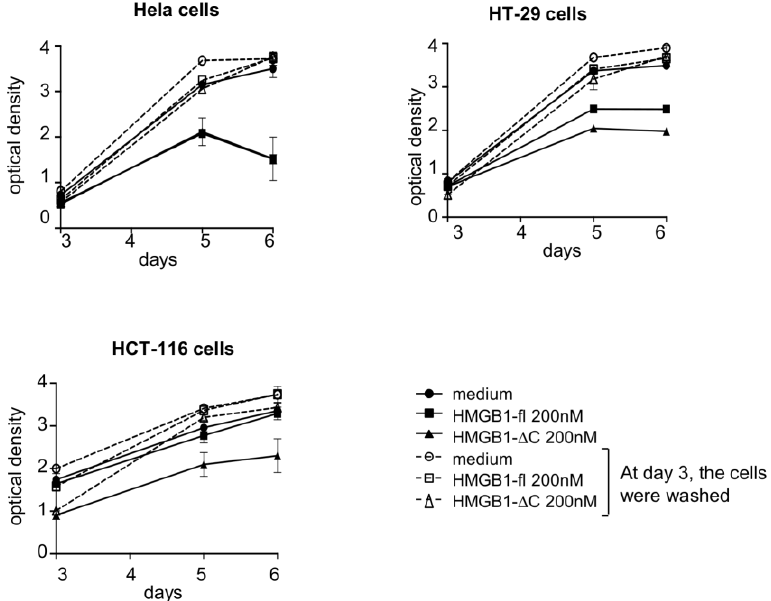
Figure 3. Cytotoxic versus cytostatic activities of HMGB1-fl and HMGB1- ∆C on cancer cells. HeLa, HT-29 and HCT-116 carcinoma cells were treated for 6 days (black symbol) with a fixed concentration (200 nM) of HMGB1-fl or HMGB1- ∆C. Alternatively, cells were treated for 3 days with a fixed concentration (200 nM) of HMGB1-fl or HMGB1- ∆C, washed and then grown for 3 additional days in a fresh HMGB1-free medium (open symbol). At days 3, 5 and 6, cells were stained by crystal violet and cell survival was assessed by measuring the optical density at 570 nm. SDs are indicated by error bars when they exceed symbol size. On the HeLa cell panel, the two solid lines corresponding to the 6-day treatment with either HMGB1-fl (black square) or HMGB1- ∆C (black triangle) appeared as merged on the graph.